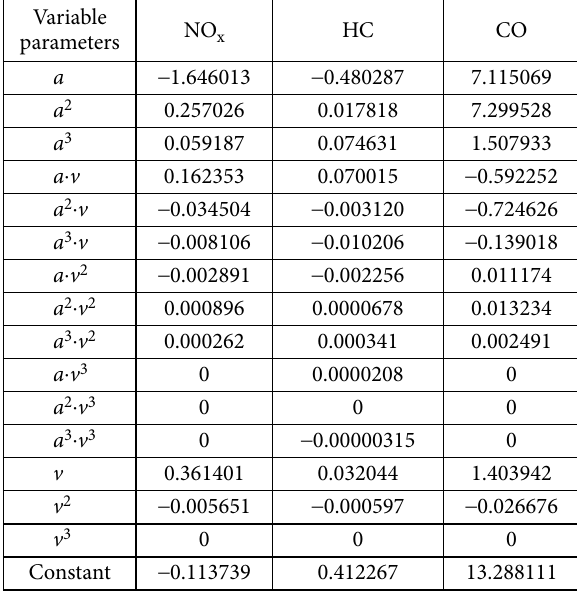
Table 4. Binary regression model coefficients